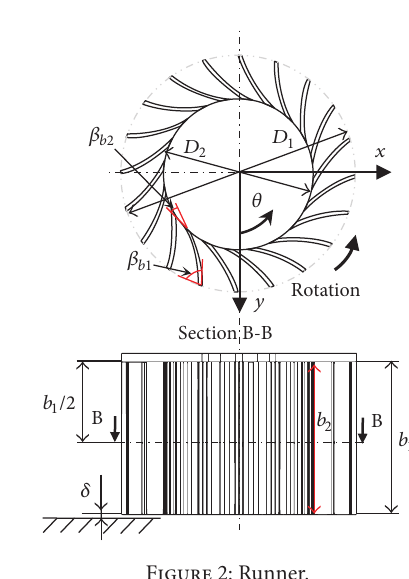
Figure 2: Runner.